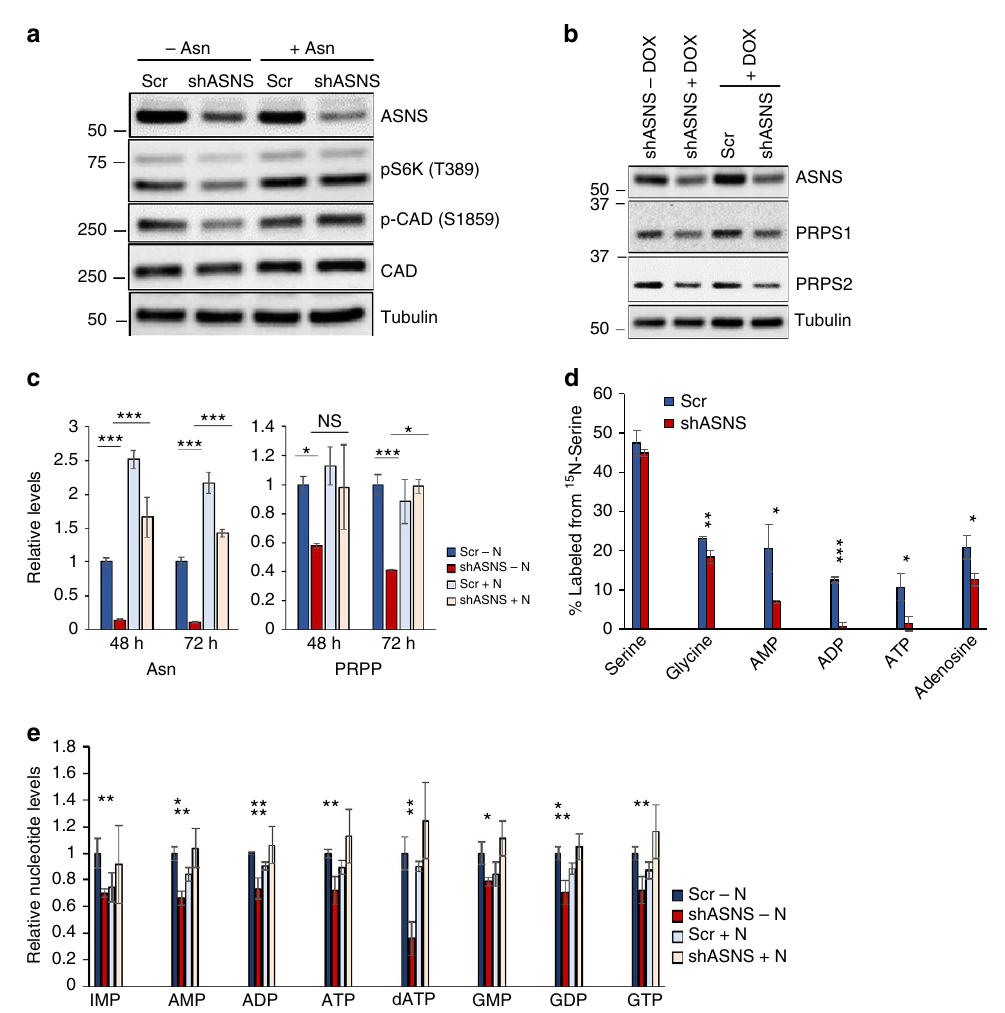
Figure 7 | Asparagine levels regulate nucleotide synthesis. ( a ) Immunoblot of HeLa lysates 48h post doxycycline-induced expression of scrambled shRNA or ASNS shRNA in asparagine-free DMEM ( (cid:2) Asn) or DMEM supplemented with 0.1mM asparagine ( þ Asn). Lysates were immunoblotted for mTOR activity marker pS6K, phospho-CAD (S1859), total CAD and tubulin. ( b ) Immunoblot of HeLa lysates with (shASNS þ Dox) and without (shASNS (cid:2) Dox) a 48-h induction of ASNS shRNA expression and HeLa lysates 48h after doxycycline induction of scrambled shRNA (Scr) or ASNS shRNA (shASNS). Lysates were immunoblotted for ASNS, PRPS1, PRPS2 and tubulin. ( c ) Relative levels of asparagine and PRPP extracted from HeLa cells 48 and 72h after doxycycline induction of scrambled shRNA (Scr) or ASNS shRNA expression as measured by LC-MS. ( d ) Percentages of the indicated metabolites labelled with 15 N extracted from HeLa cells labelled with exogenous 15 N-serine (50:50 15 N:14 N) for 24h at 24h post induction of scrambled shRNA (Scr) or ASNS shRNA expression. ( e ) Relative levels of the indicated intracellular metabolites extracted from HeLa cells 72h after doxycycline induction of scrambled shRNA (Scr) or ASNS shRNA expression as measured by LC-MS. Error bars denote s.d. of the mean ( n ¼ 3). P values were calculated by the Student’s t -test: * P o 0.05; ** P o 0.01; *** P o 0.001. NS, not